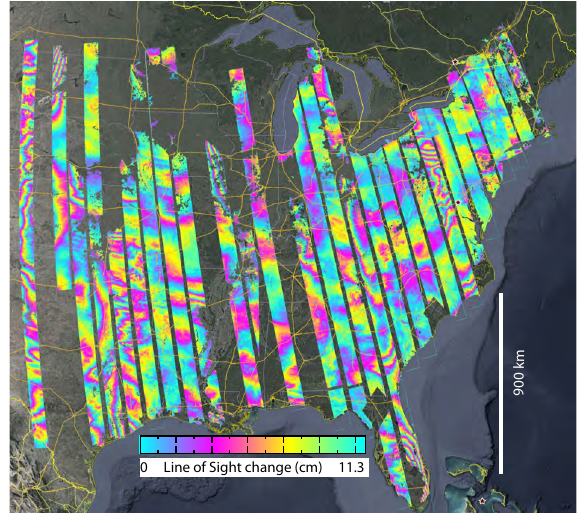
Figure 2. Selected ALOS-1 interferograms (each color cycle corresponds to 11.3 cm of line-of-sight displacement) covering the eastern USA that were processed in this study (Table 2), illustrating the high coherence possible over much of the region. Data gaps include areas that were decorrelated and could not be unwrapped, where there are holes in the Shuttle Radar Topography Mission digital elevation model (SRTM DEM), and for three paths of data that had errors and were not processed. Longer spatial scales are dominated by ionospheric, atmospheric, and other effects, limiting our constraints to shorter spatial scale features that are not visible at the scale of this figure (see section on deformation detection and error analysis). The fairly small number of available ALOS-1 acquisitions means that the historical SAR imagery is not sensitive to larger spatial-scale signals such as glacial isostatic adjustment. We expect this situation to improve as more L-band data are acquired in the future, and as methods for isolating the ionospheric effects